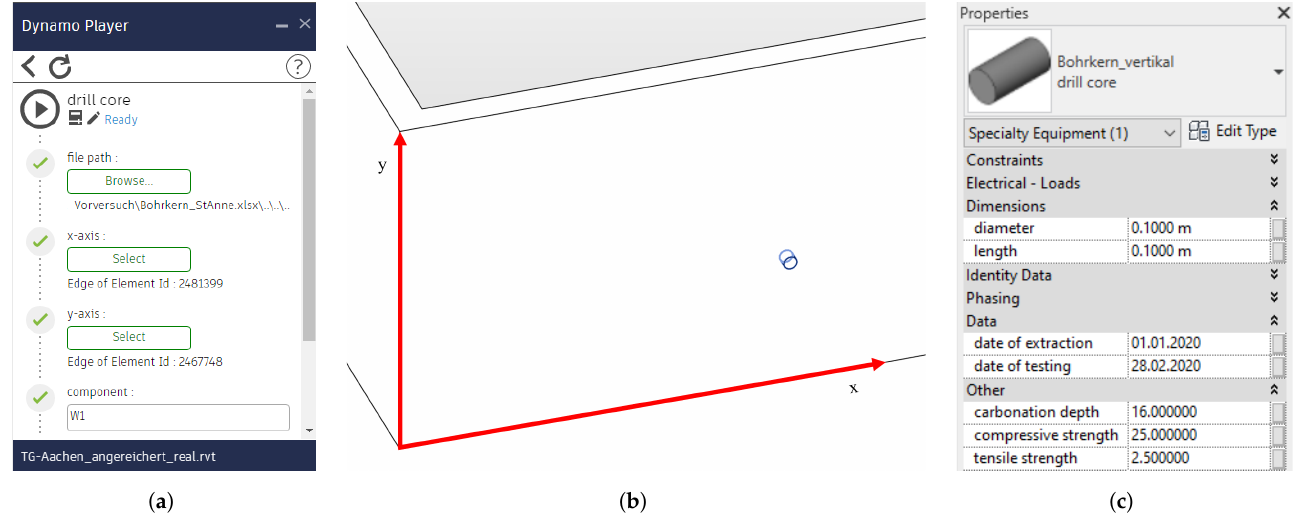
Figure 1. ( a ) GUI of the Dynamo Player; ( b ) implementation of the drill core in BIM with the relative coordinate system (red lines); ( c ) properties of the drill core.